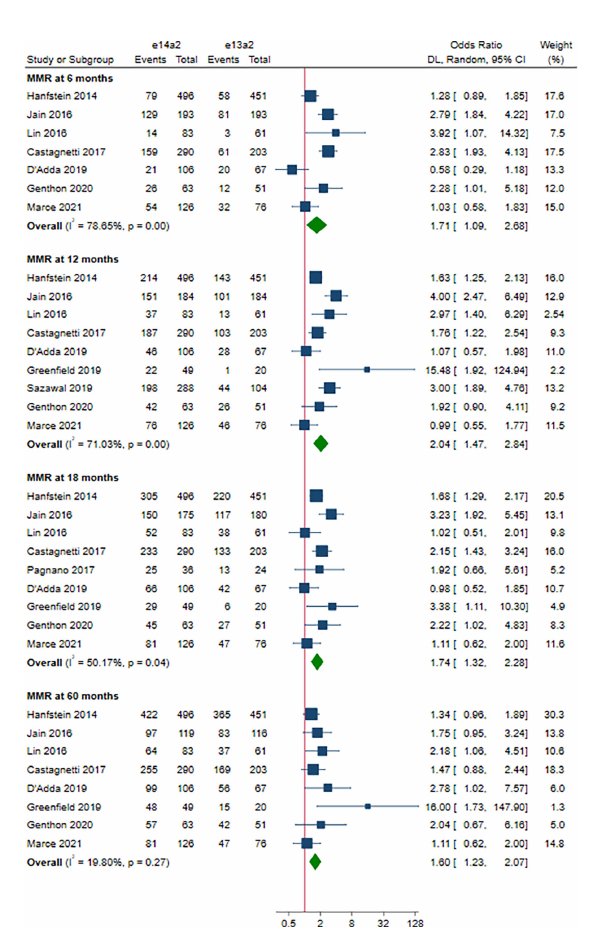
FIGURE 2 | E14a2 versus e13a2: rate of patients who achieved major molecular response at 6, 12, 18 and 60 months.